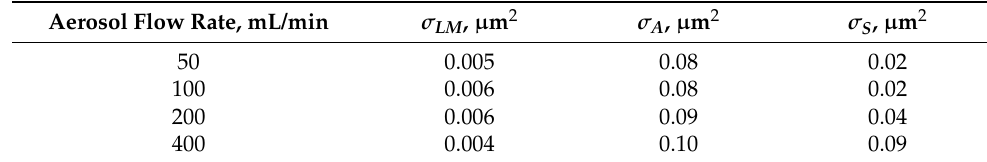
Table 1. Extinction cross-sections of laser-modified NPs, initial agglomerates, and thermally modified NPs at the wavelength of 1053 nm.